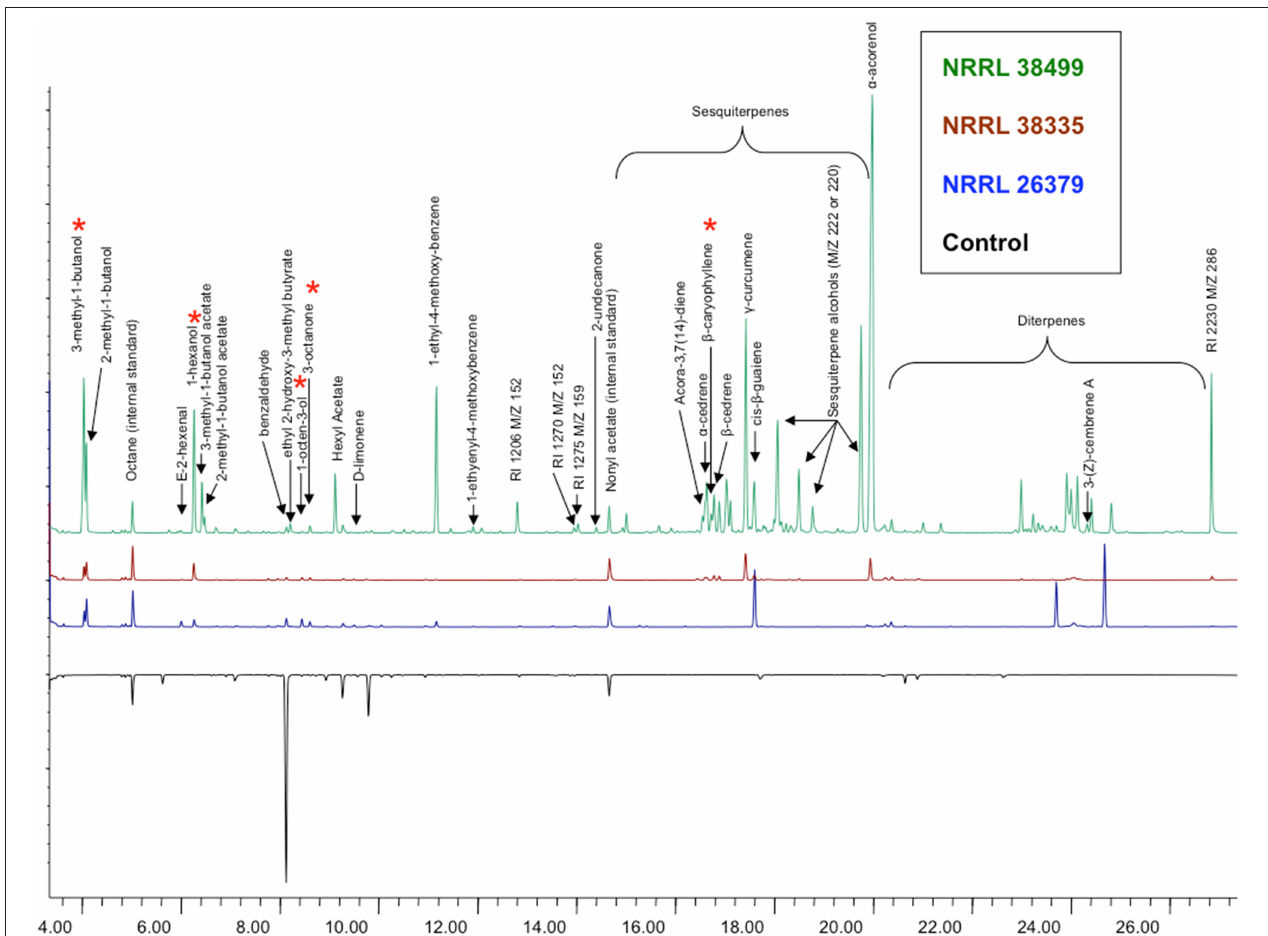
FIGURE 10 | Volatile compounds produced by F. oxysporum . Headspace volatiles from no fungus (bottom, control), NRRL 38499, NRRL 26379, and NRRL 38335 cultured on PDA were analyzed using GC-MS. Asterisks denote compounds that have been shown to affect plants in previously published studies.